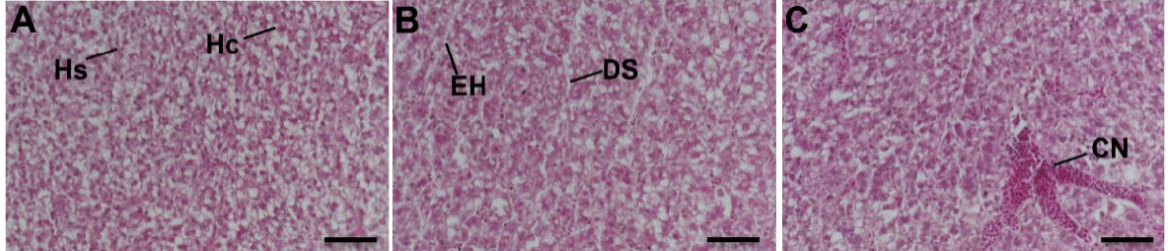
Figure 5. Liver histomorphology of medaka exposed to ( A ) 0 items/L (control), ( B ) 10 items/L, and ( C ) 10 4 items/L (H&E. Scale bar, 50 µ m). Hc, Hepatocyte; Hs, Hepatic sinusoid; DS, Dilated sinusoids; EH, Edema of hepatocytes; CN, Congestion.